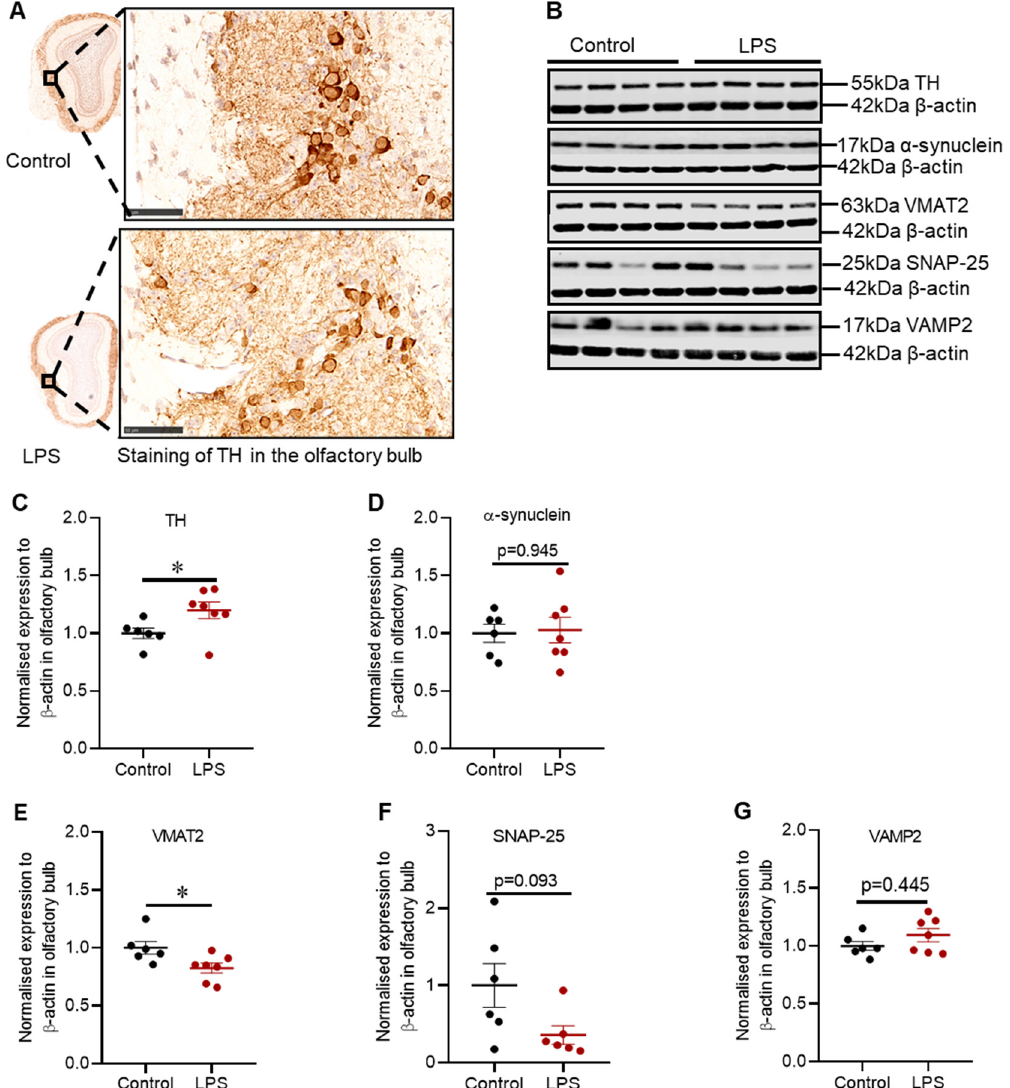
Figure 4. Intrastriatal administration of LPS altered the expression of TH and synaptic proteins in the olfactory bulb of C57BL/6 mice. ( A ) Representative images for immunohistochemical detection of TH in the olfactory bulb. ( B ) Representative immunoblots for TH, α -synuclein, VMAT2, SNAP-25 and VAMP2 proteins in the olfactory bulb. ( C ) Densitometric analysis of TH protein. ( D ) Densitometric analysis of α -synuclein protein. ( E ) Densitometric analysis of VMAT2 protein. ( F ) Densitometric analysis of SNAP-25. ( G ) Densitometric analysis of VAMP2. The results are presented as mean ± SEM (control n = 6; LPS n = 6–7). Statistical analysis was performed with a Mann–Whitney test, p < 0.05 (*). Immunohistochemical detection of TH (scale bar: 50 µm; microscopic magnification: X400) (control n = 5; LPS n = 5).